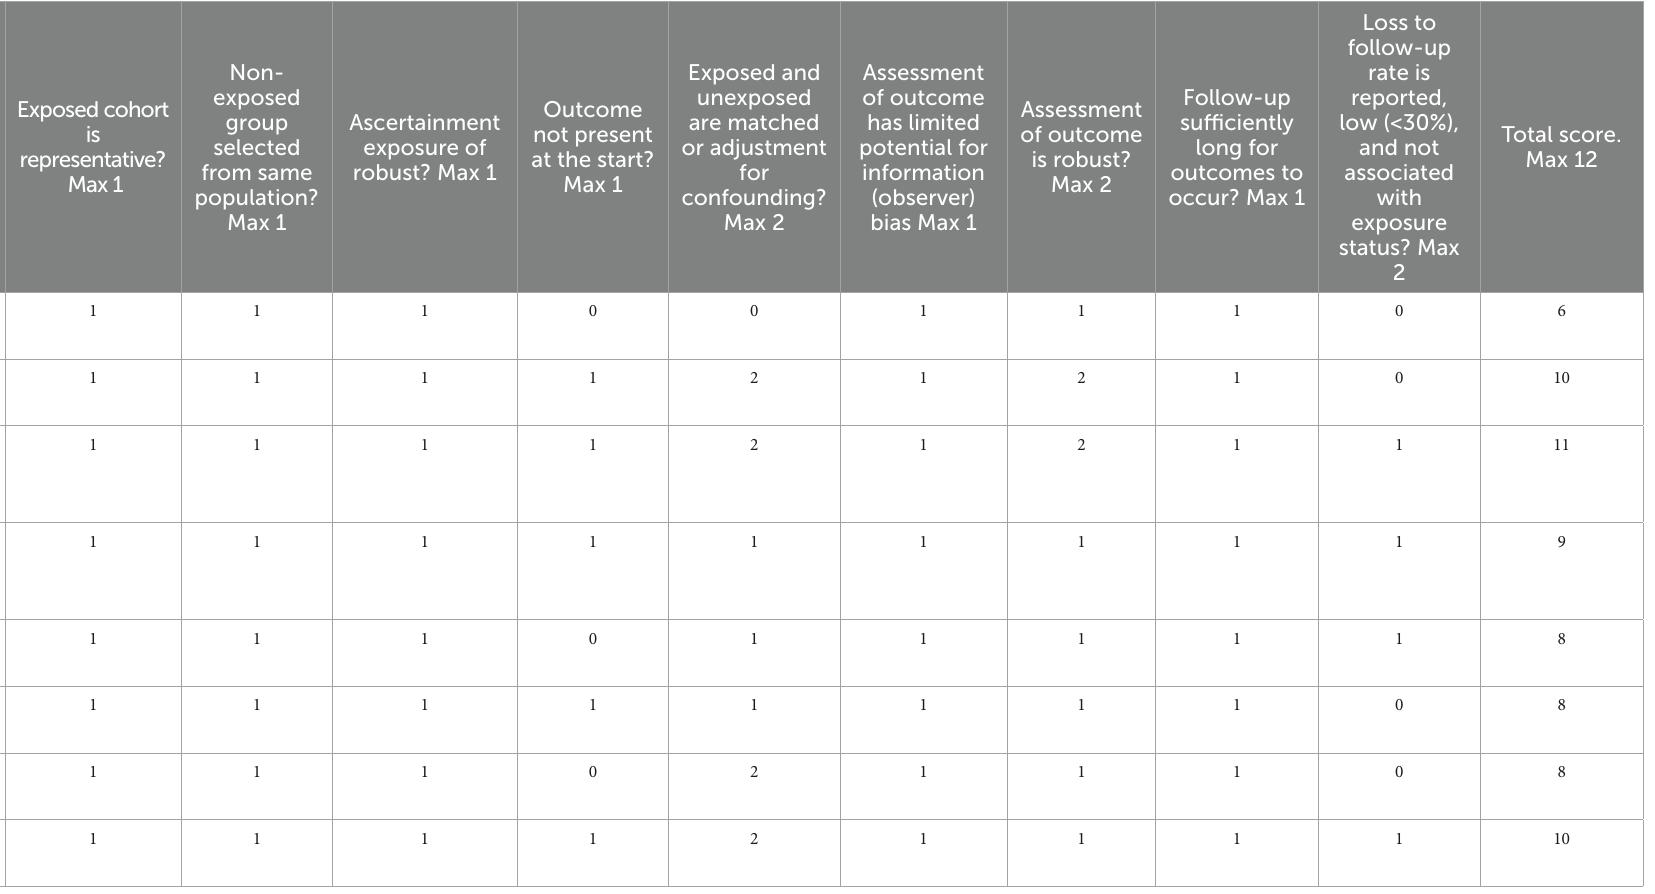
TABLE 5 Risk of bias in cohort